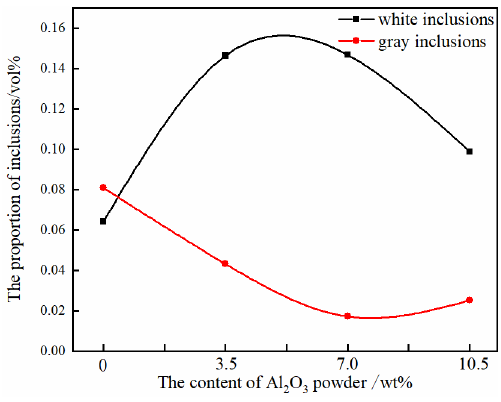
Figure 7. The number of precipitates in metal particles.